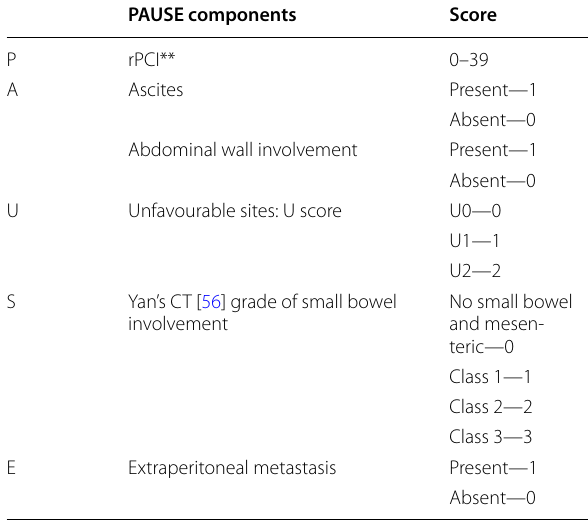
**rPCI cut-off used in practice is variable for different types of peritoneal malignancy based on the tumour biology. Based on local practice, rPCI could be dichotomised for the purposes of clinical usage and research